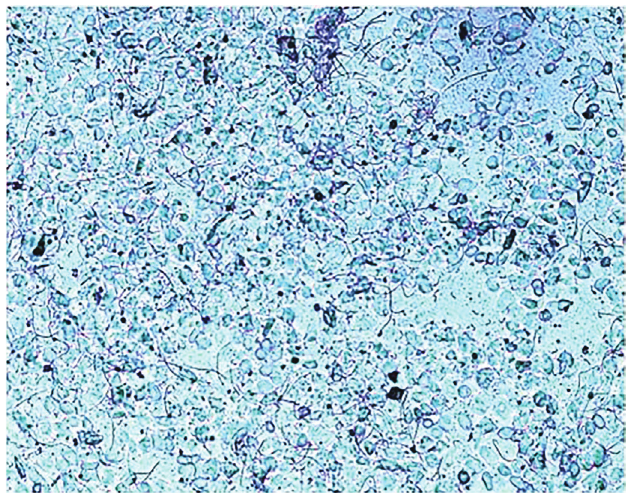
FIGURE 1 - Vaginal smear of female rats after copulation, presence of sperm in the